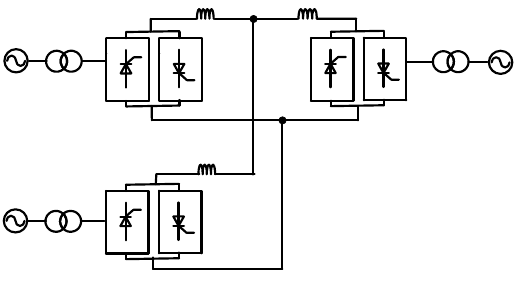
Figure 3. Configuration of the line ‐ commutated converter based multi ‐ terminal LFAC (LCC ‐ MTLF).